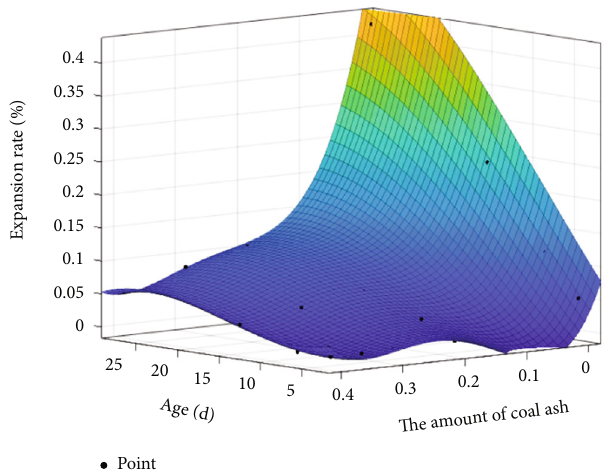
Figure 16: Quartic fi tting diagram of coal ash content, age, and expansion rate (cement alkali content